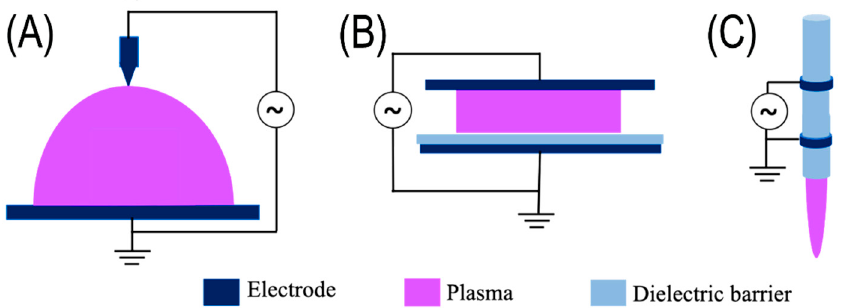
Figure 1. Configuration of basic NTP systems: ( A ) corona discharge; ( B ) dielectric barrier discharge; ( C ) plasma jet (adapted and modified from